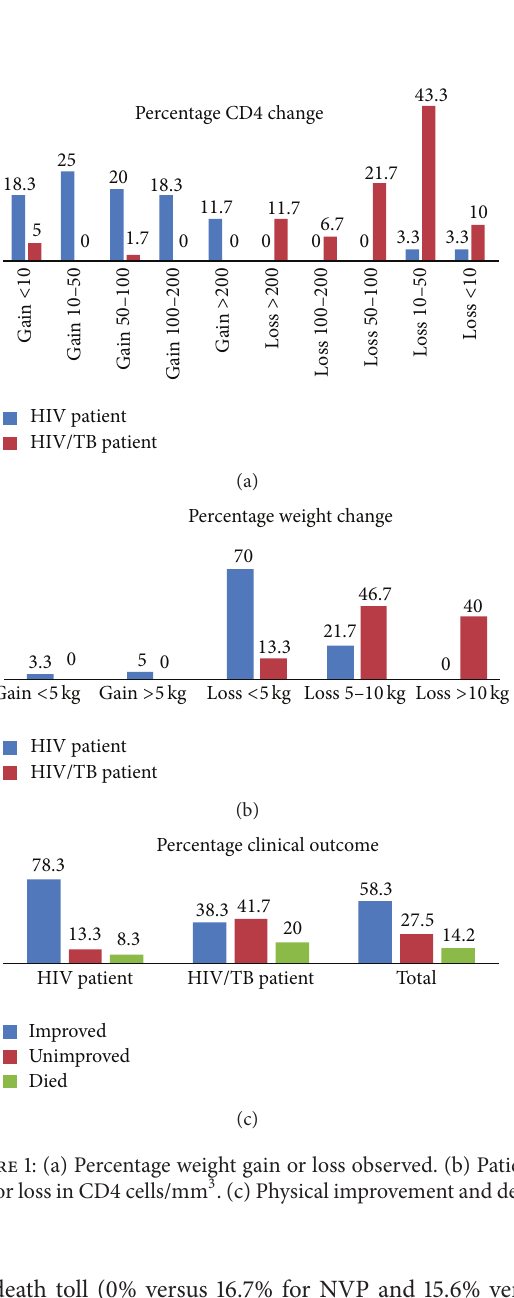
the death toll (0% versus 16.7% for NVP and 15.6% versus 27.8% for EFV).